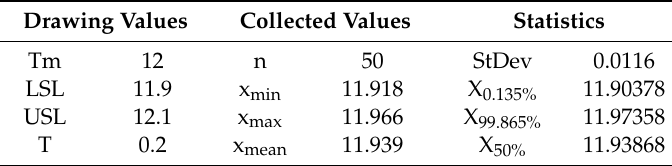
Table 5. Machine capability analysis for the H dimension.